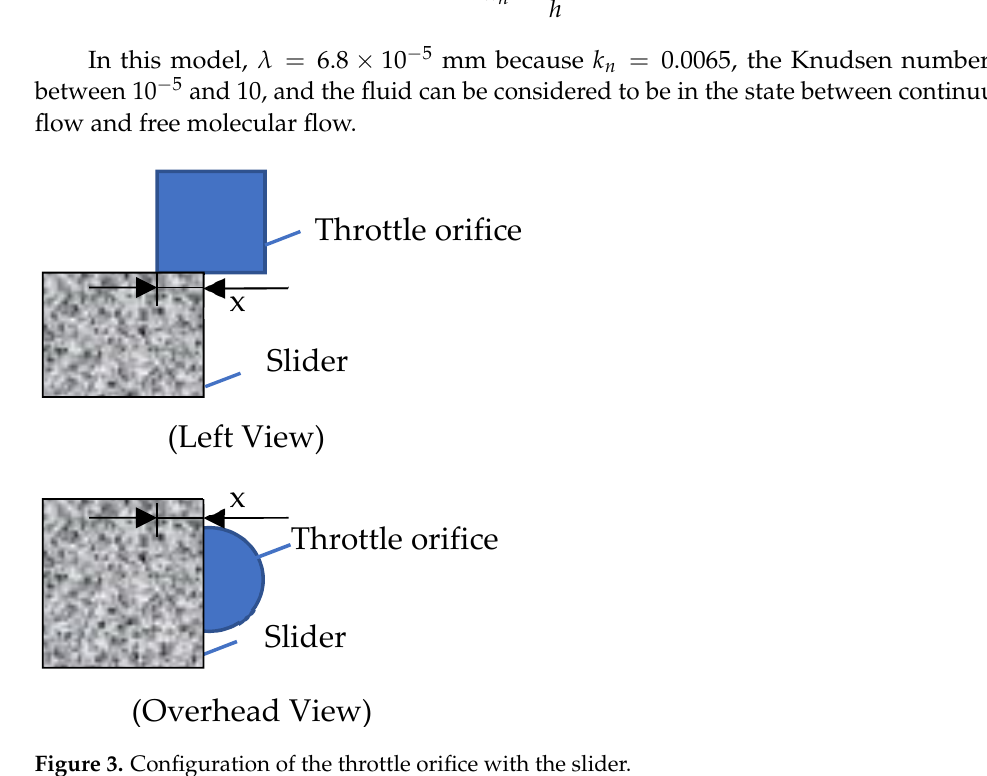
Figure 3. Configuration of the throttle orifice with the